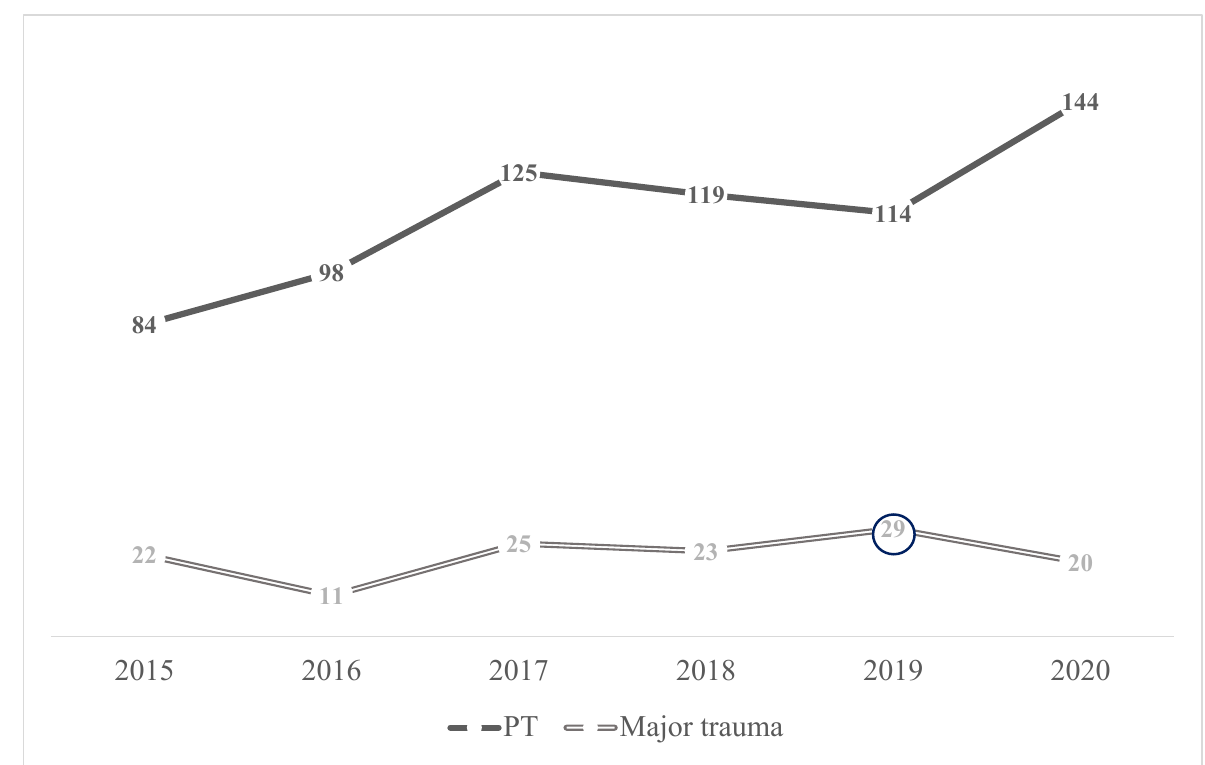
Figure 1. Distribution of overall PT and major trauma (ISS ≥ 12) over time. Description: an increasing overall trend of PT was reported in the study period, with a fluctuation of the percentage of major trauma peaking in 2019. Sixty-six percent were male, with a mean age of 9.88 (±5.17) years. Table 1 shows the baseline population characteristics over time. Table 1. Baseline population characteristics.